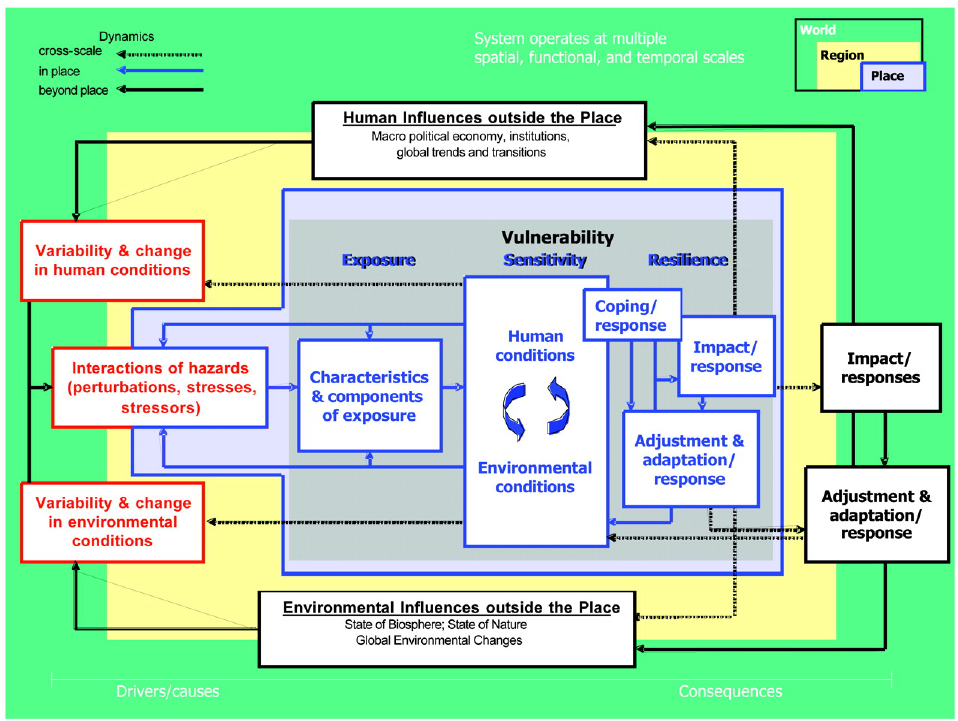
Figure 2. Vulnerability framework